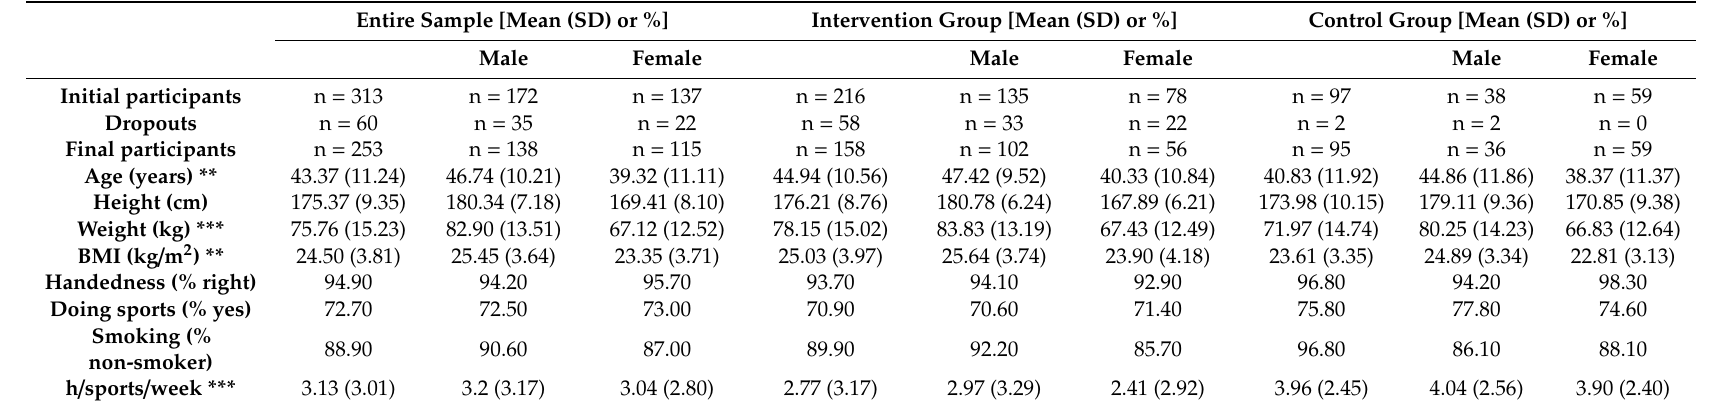
Table 1. Baseline demographic characteristics of participants in the intervention and the control groups. Significant di ff erences in the baseline between IG and CG are marked with